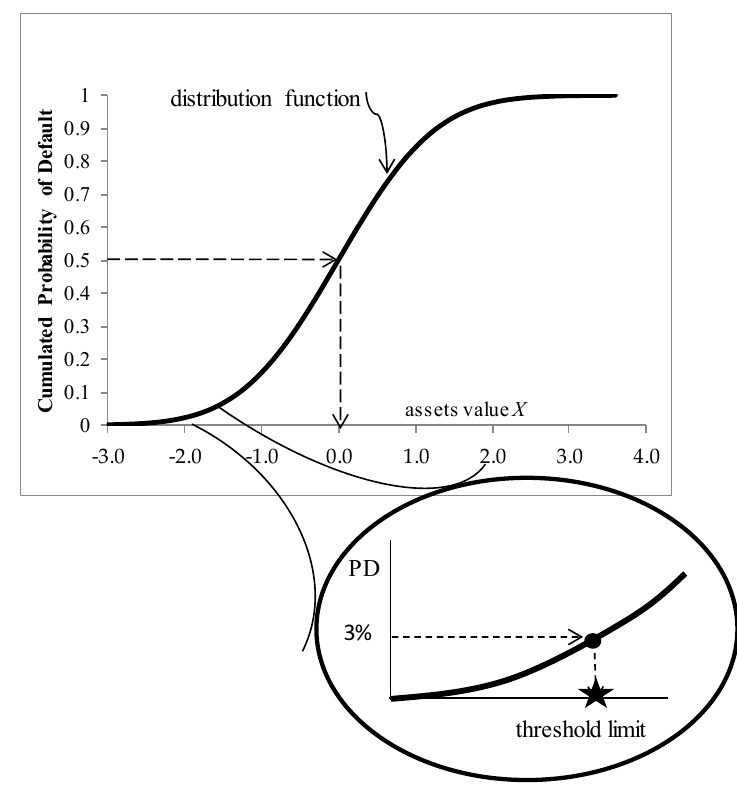
Figure 2. Threshold limit calculation for assets’ value.